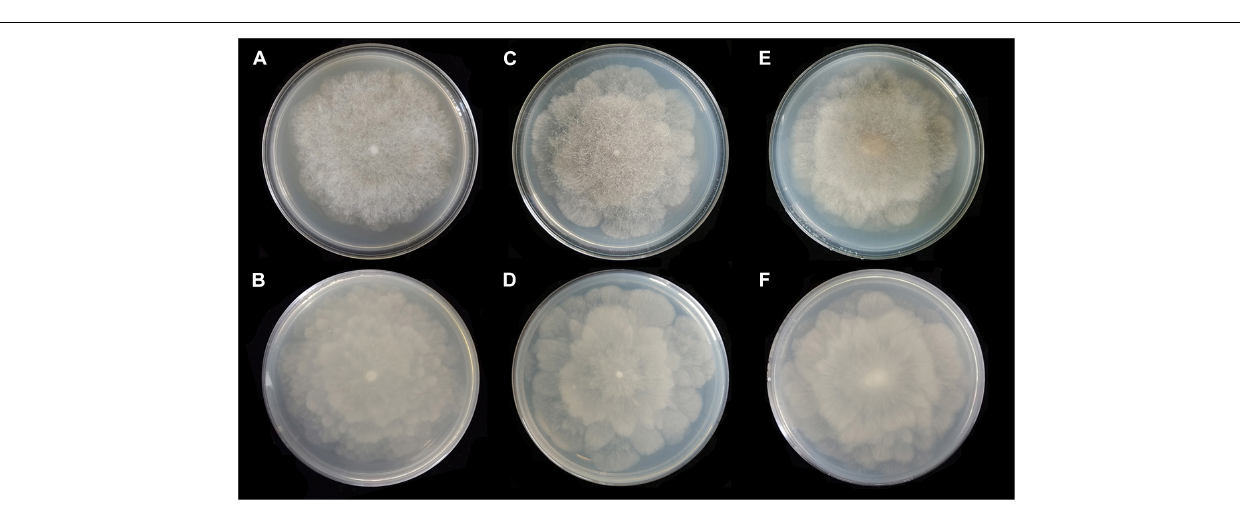
cylindrical to oval, hyaline, smooth, 3.0–4.5 × 2.0–3.0(–3.5) µ m. Chlamydospores absent. Zygospores not